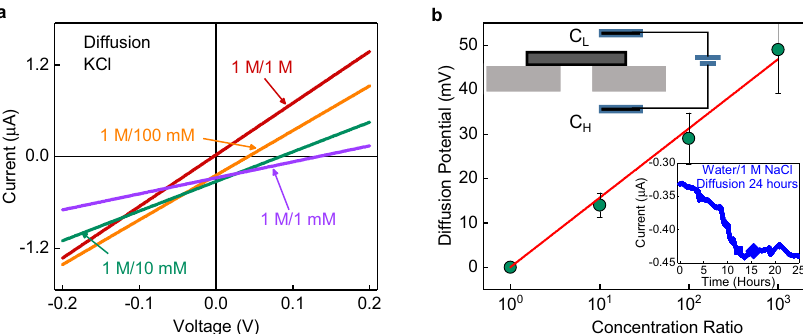
Fig. 2 Poor ion selectivity of intercalated graphite. a Current – voltage characteristics for various concentrations of KCl under a concentration gradient. The concentration of one of the reservoirs ( C H ) was fi xed to 1 M and the other ( C L ) was varied from 1 M to 1 mM. b The estimated diffusion potential is plotted as a function of the concentration ratio. The red solid line indicates the best fi t to the measured data. The error bar provides an estimate of the spread in the diffusion potential in repeated measurements. The top inset shows the schematic of the drift-diffusion experiments. The bottom inset shows the diffusion current measured over a duration of 24 h, with water on one side of the sample and 1 M NaCl on